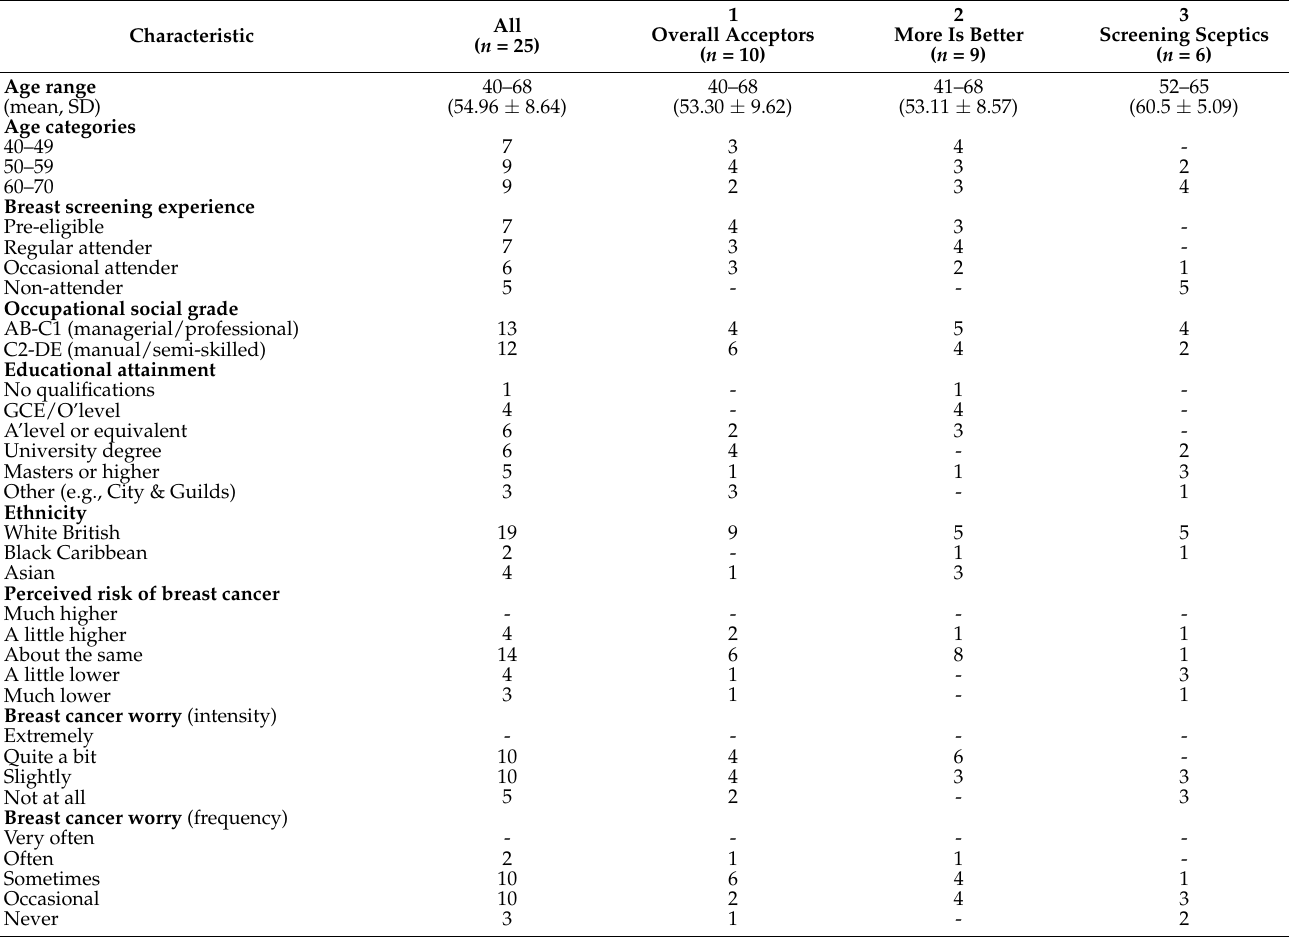
1 2 Overall Acceptors More Is Better ( n = 10) ( n = 9)